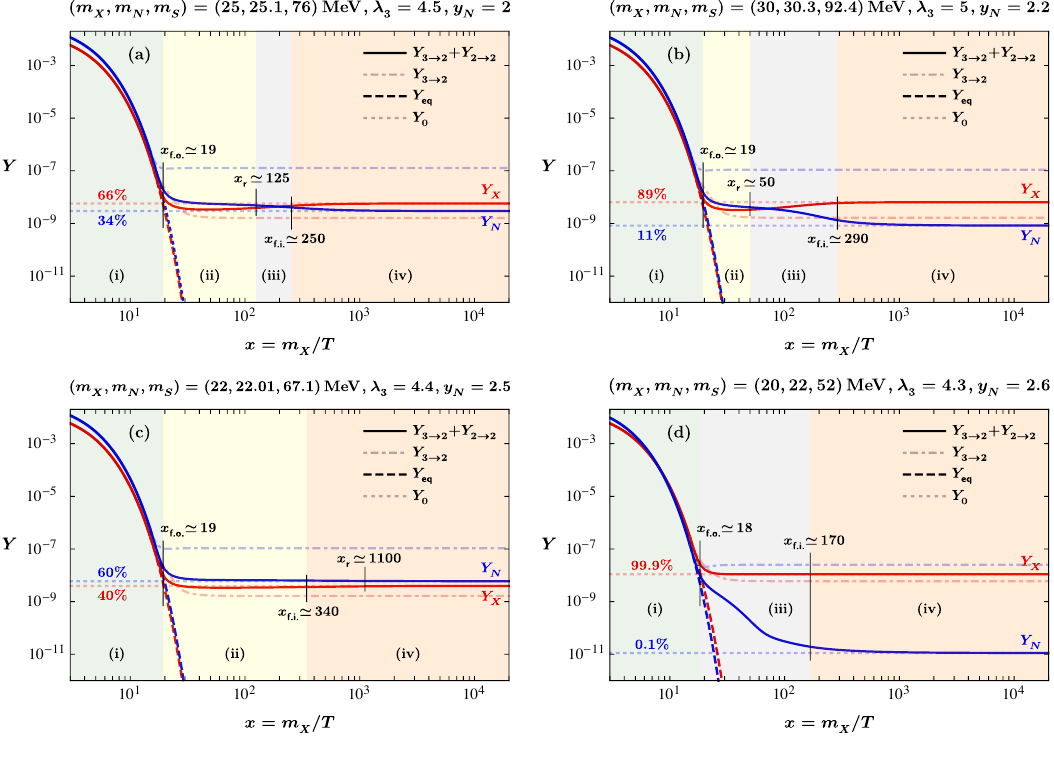
Figure 7 . Cosmological evolution of the comoving number densities in the presence of the 3 → 2 and 2 → 2 processes for some benchmark points in the r SIMP model for r